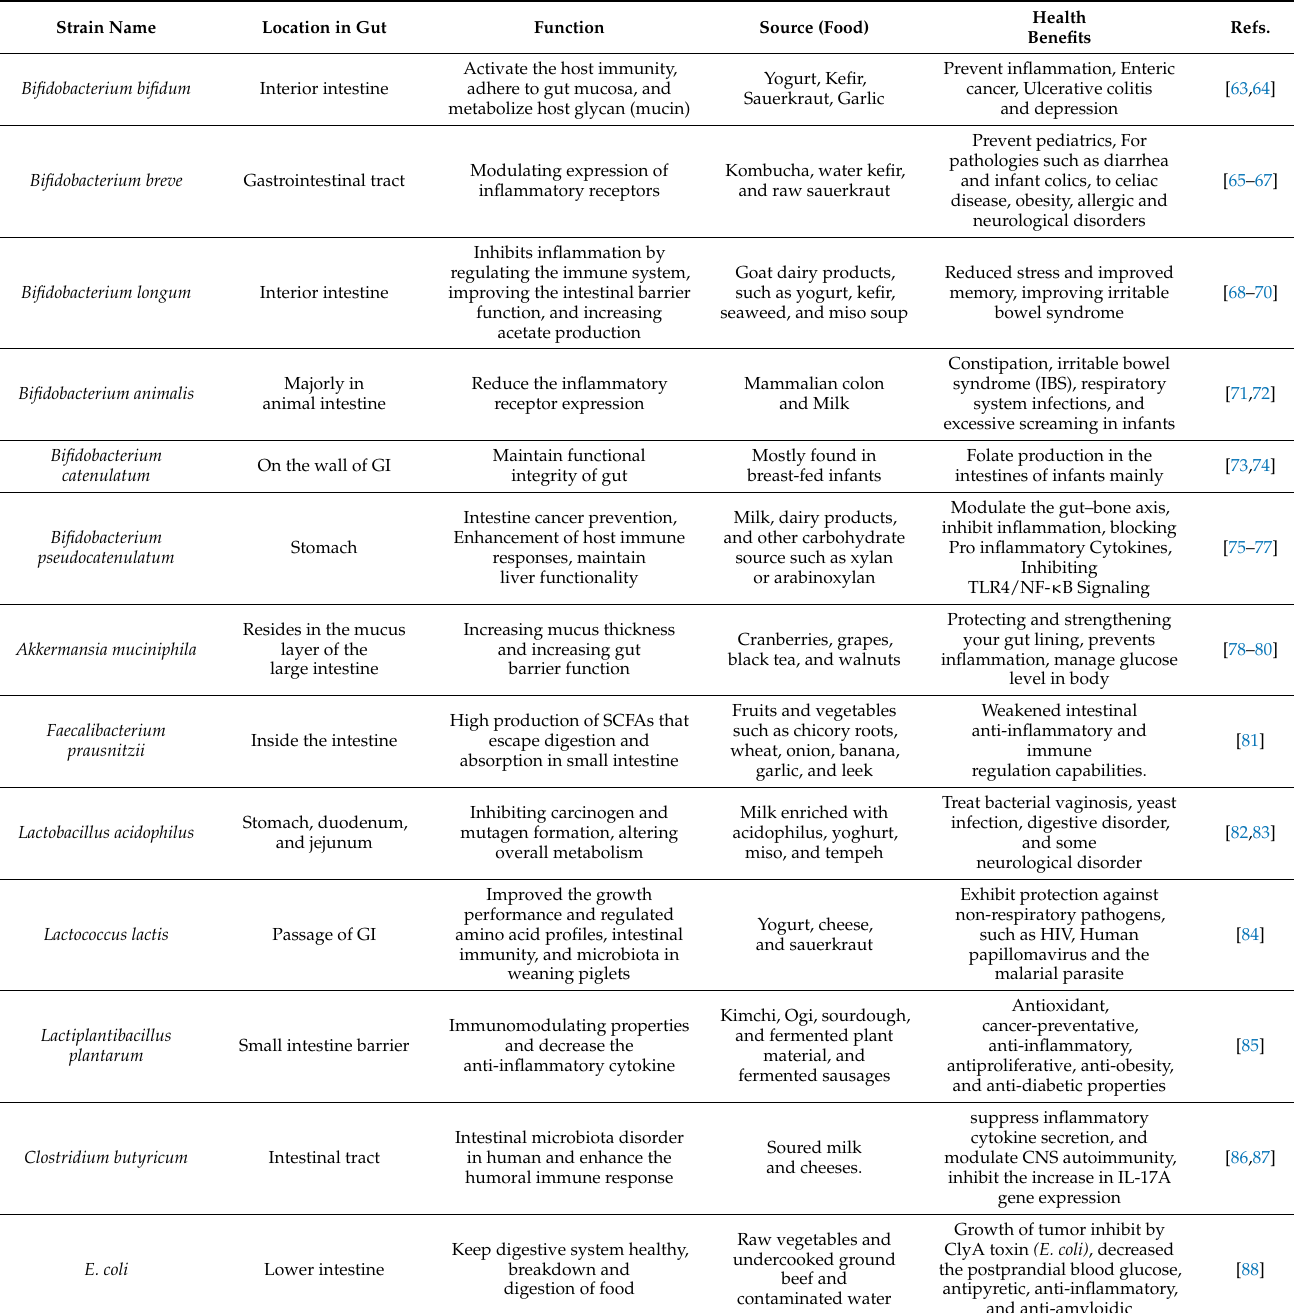
Table 2. Popular probiotic strains, their location in the gut, function in the human body, and health benefits with their source